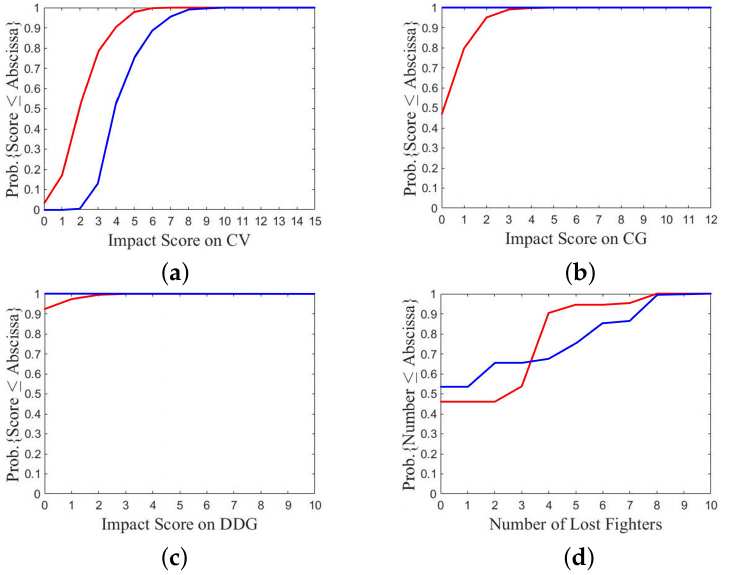
Figure 8. (A2/B3) Cumulative distribution of impact score on ( a ) CV ( b ) CG, ( c ) DDG, ( d ) fighters; over 400 games with two P 2 SO runs, ———: fleet A, ———: fleet B.